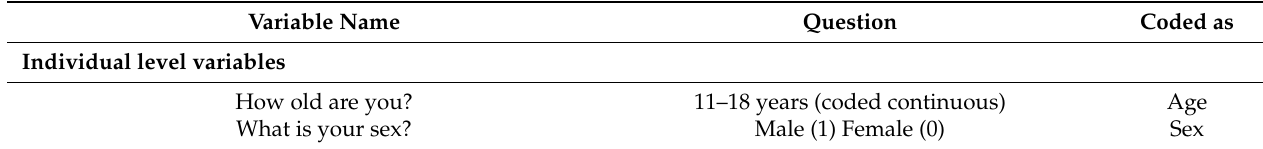
Table 1. The independent variables derivation from Mauritius, GSHS survey data